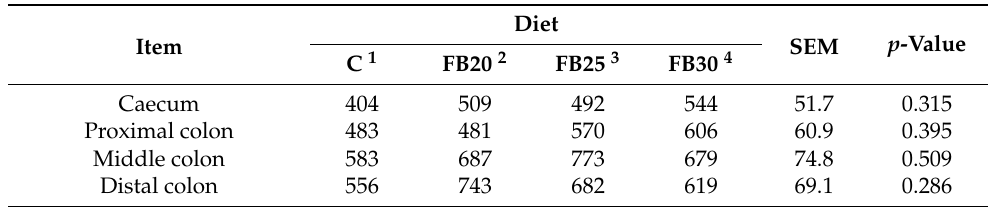
Table 6. β -glucosidase activity in the large intestine of pigs fed diets with extruded faba bean seeds, U/g digesta.